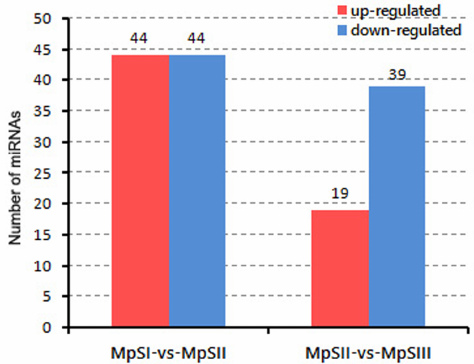
Figure 2. The numbers of DEmiRs between developmental phases of Pongamia seeds. The values in red and blue indicate the numbers of up-regulated and down-regulated miRNAs, respectively.